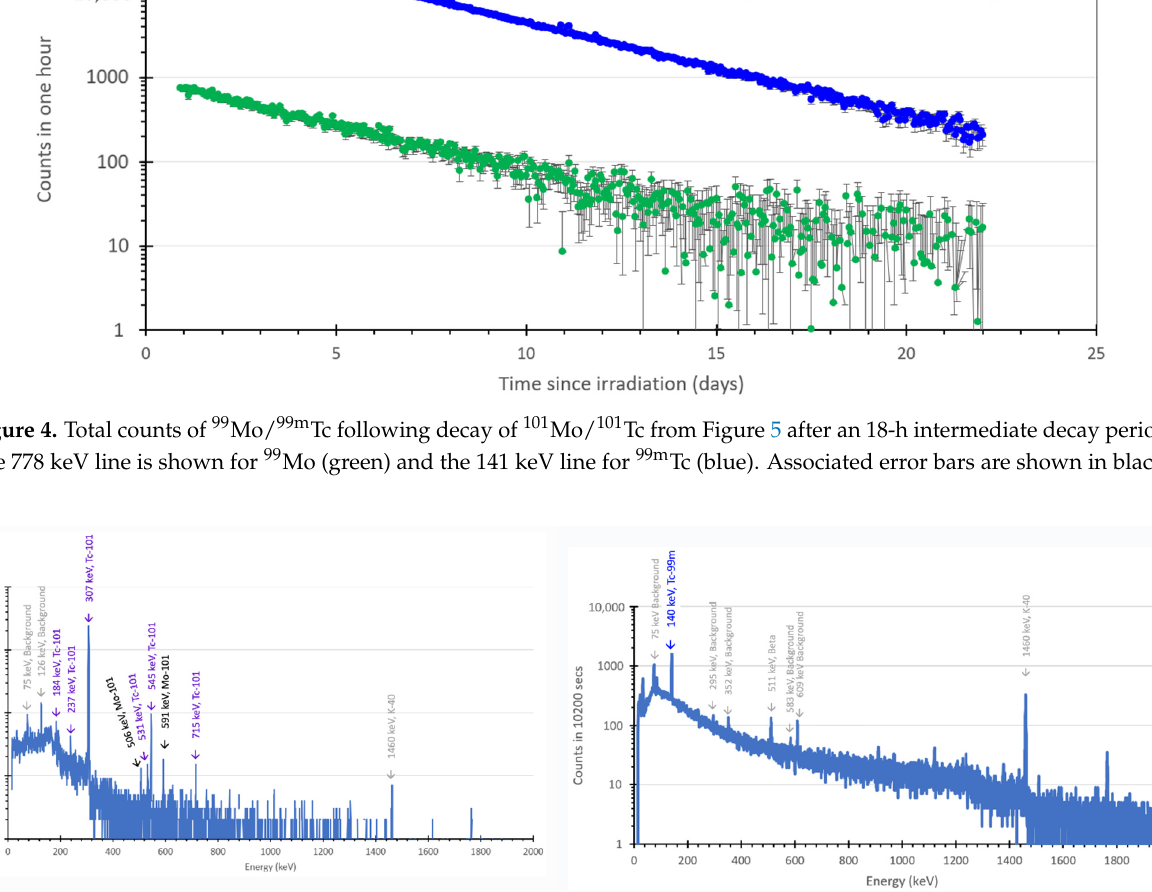
Figure 4. Total counts of 99 Mo/ 99m Tc following decay of 101 Mo/ 101 Tc from Figure 5 after an 18-h intermediate decay period. The 778 keV line is shown for 99 Mo (green) and the 141 keV line for 99m Tc (blue). Associated error bars are shown in black.